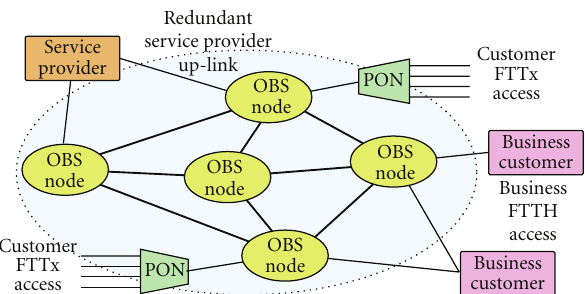
Figure 18: Example network architecture—evidently contains practical networks multiples of the exemplary units